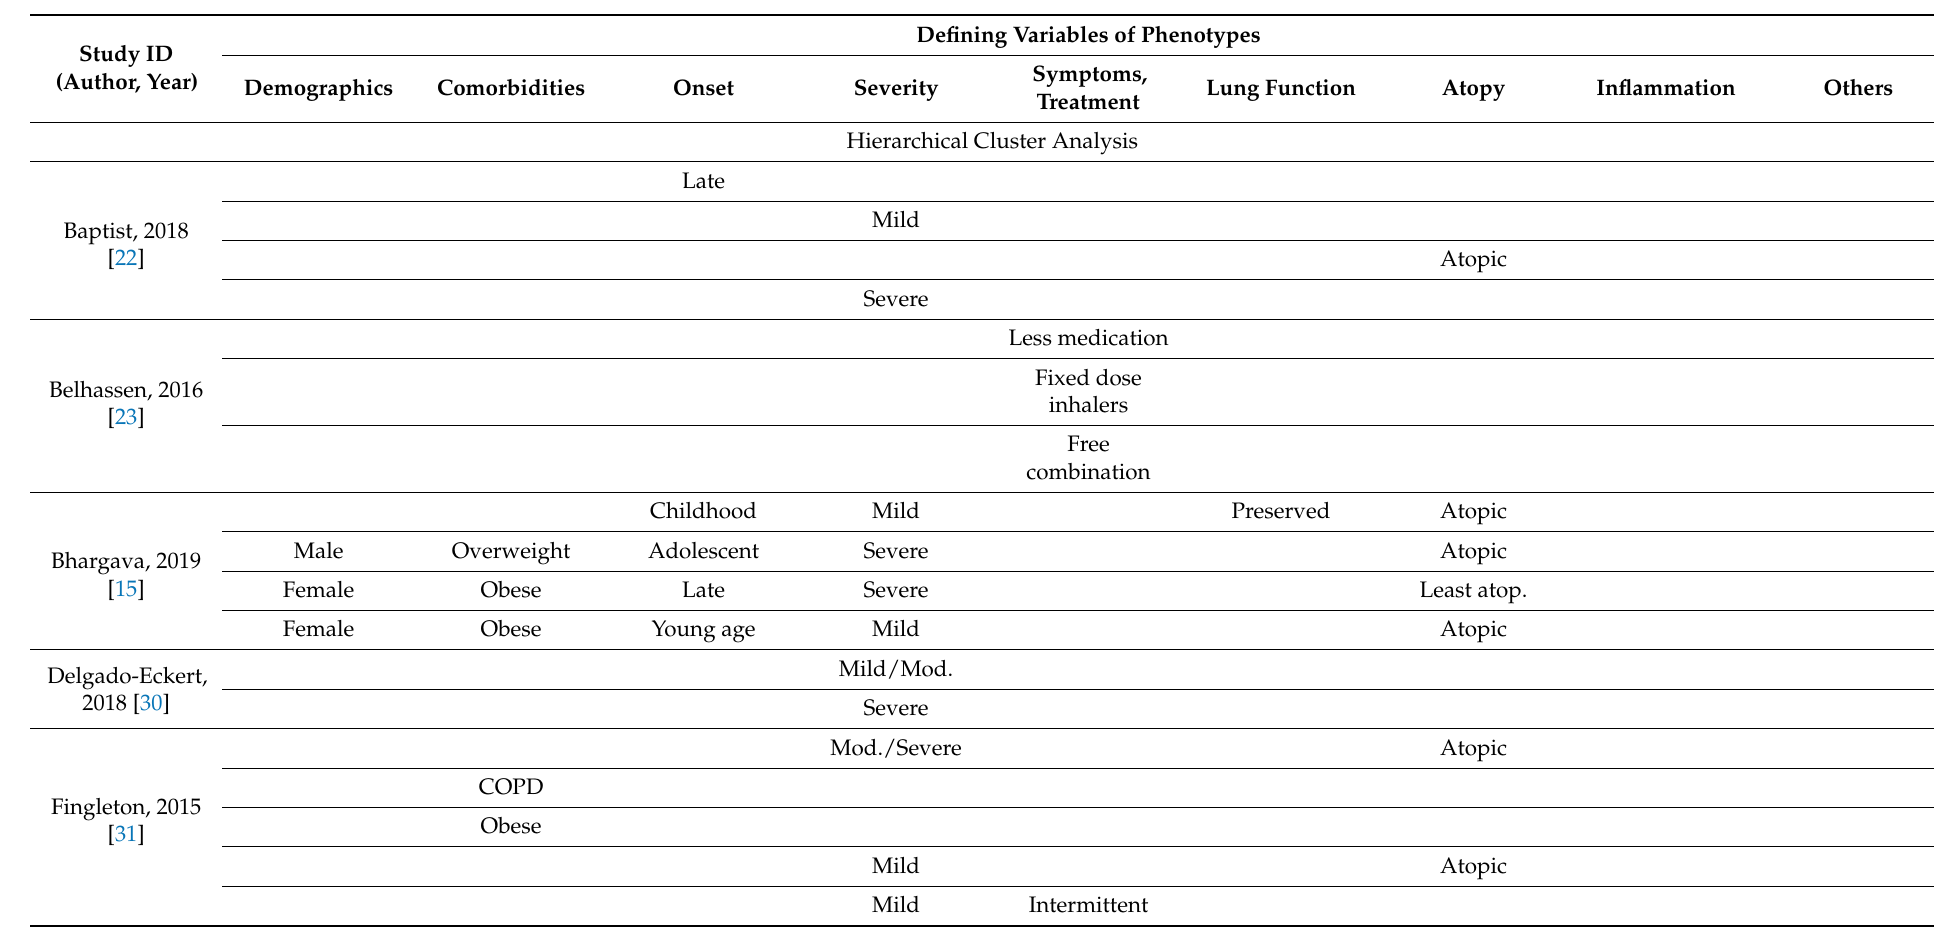
Table 4. Characterization of the phenotypes obtained in each study according to the defining variables (column), with each row within each study corresponding to one